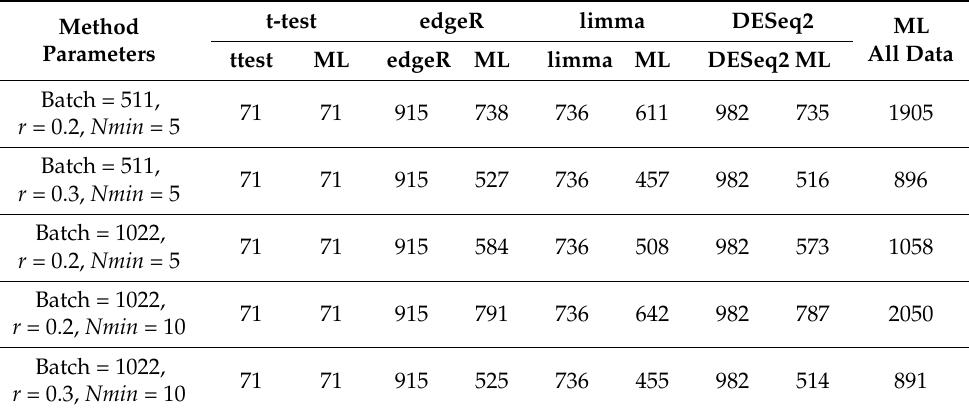
Table 2. The number of differentially expressed genes selected via Mahalonobis distance for different batch sizes.